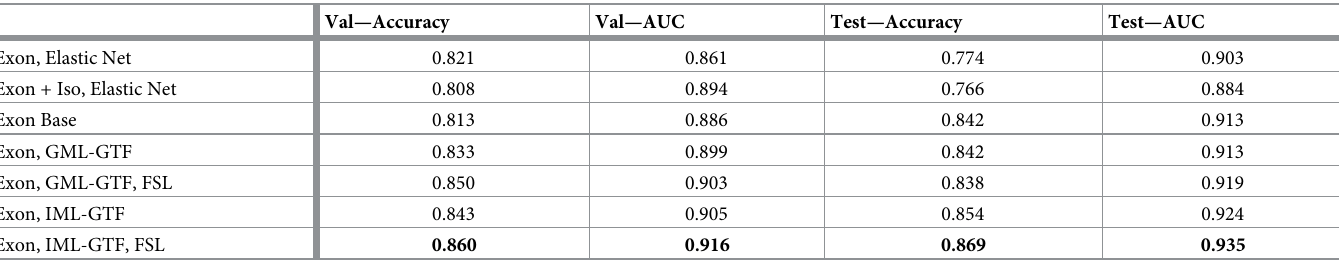
Table 3. Predictive performance of various models using exon-level data, including elastic net for